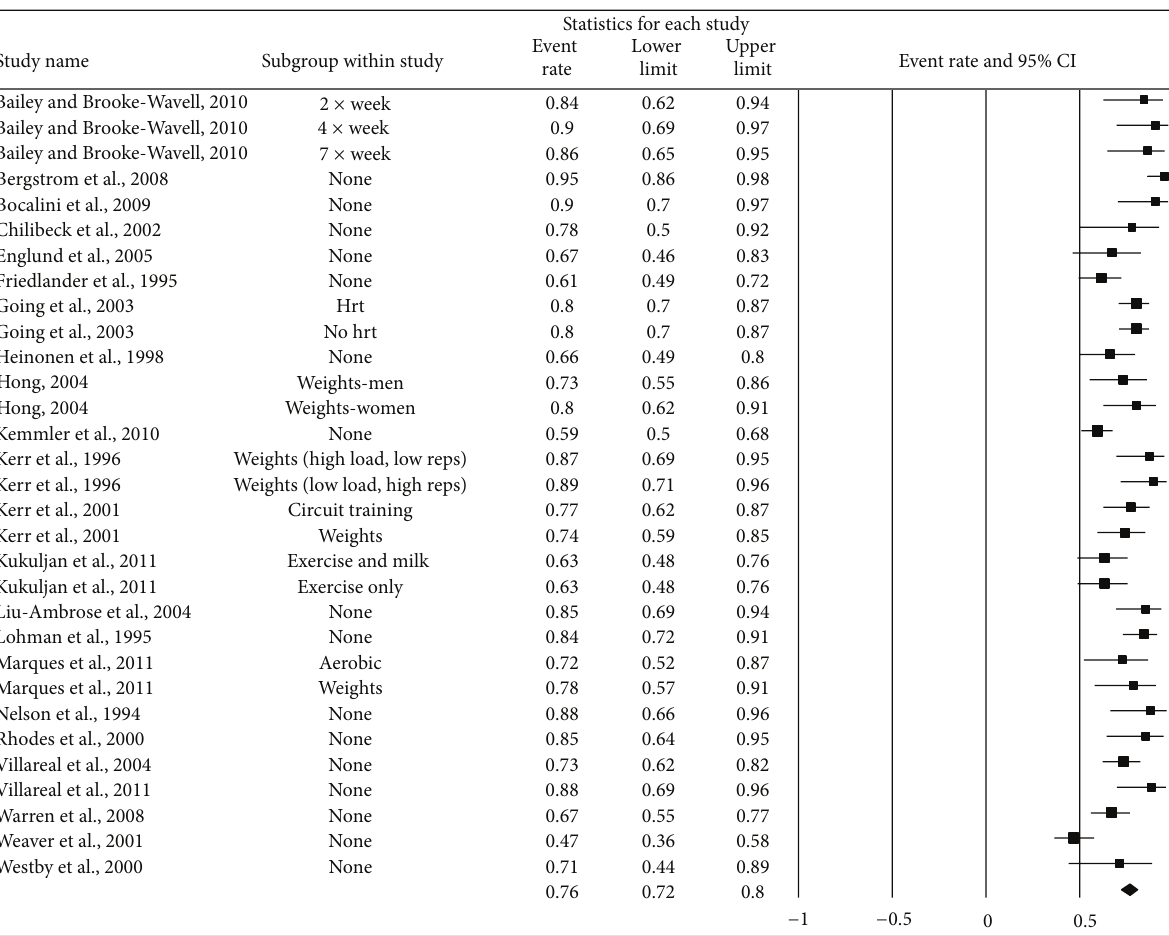
Figure 9: Forest plot for compliance (group level). Forest plot for compliance at the group level. The black squares represent the mean event rate while the left and right extremes of the squares represent the corresponding 95% confidence intervals. The middle of the black diamond represents the overall mean event rate while the left and right extremes of the diamond represent the corresponding 95% confidence